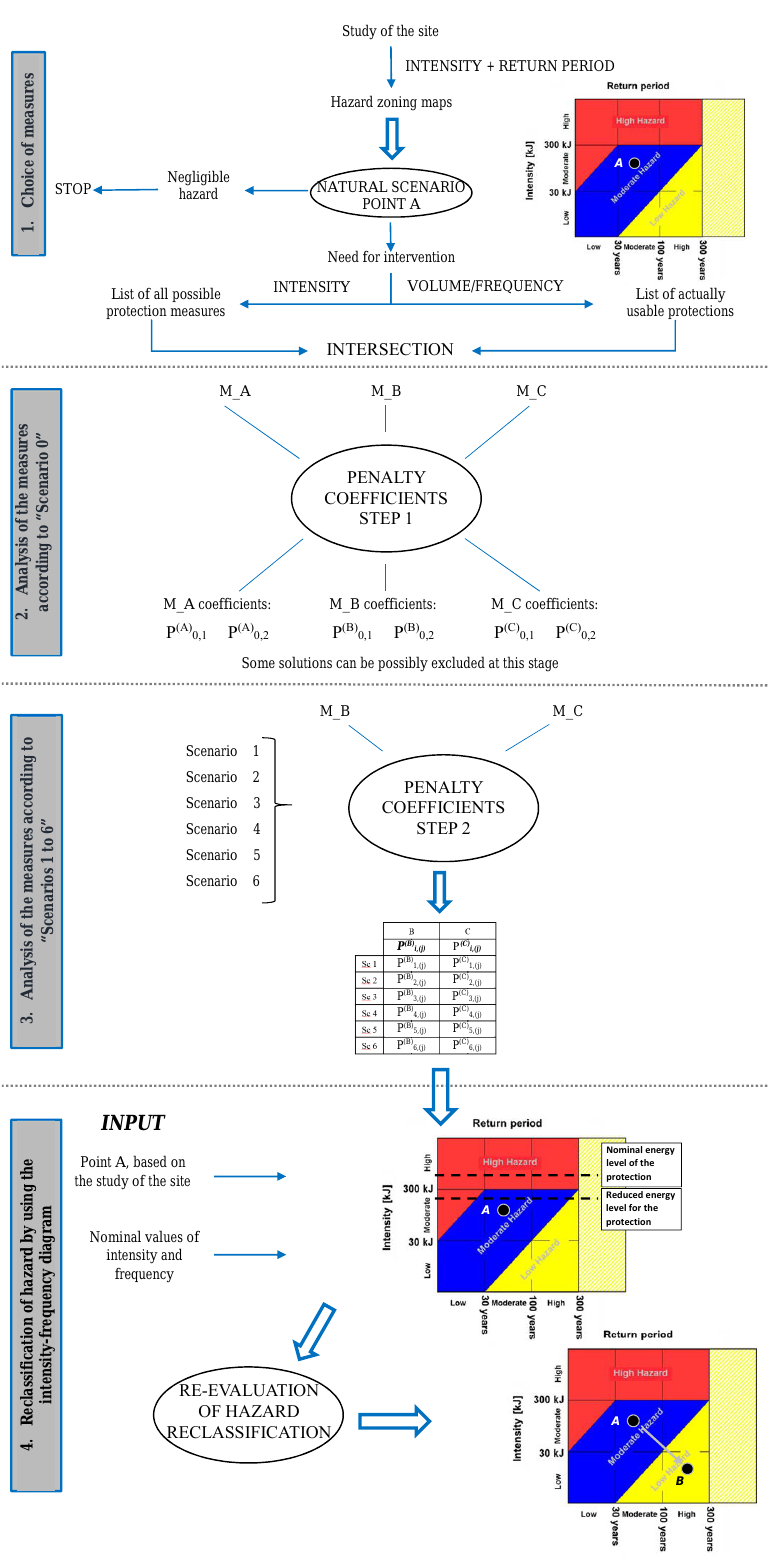
Figure 4. Scheme of the methodology for evaluating the effectiveness of rockfall protections and reclassifying hazards (modified from Grisanti and Prina Howald, 2014, 2015a,